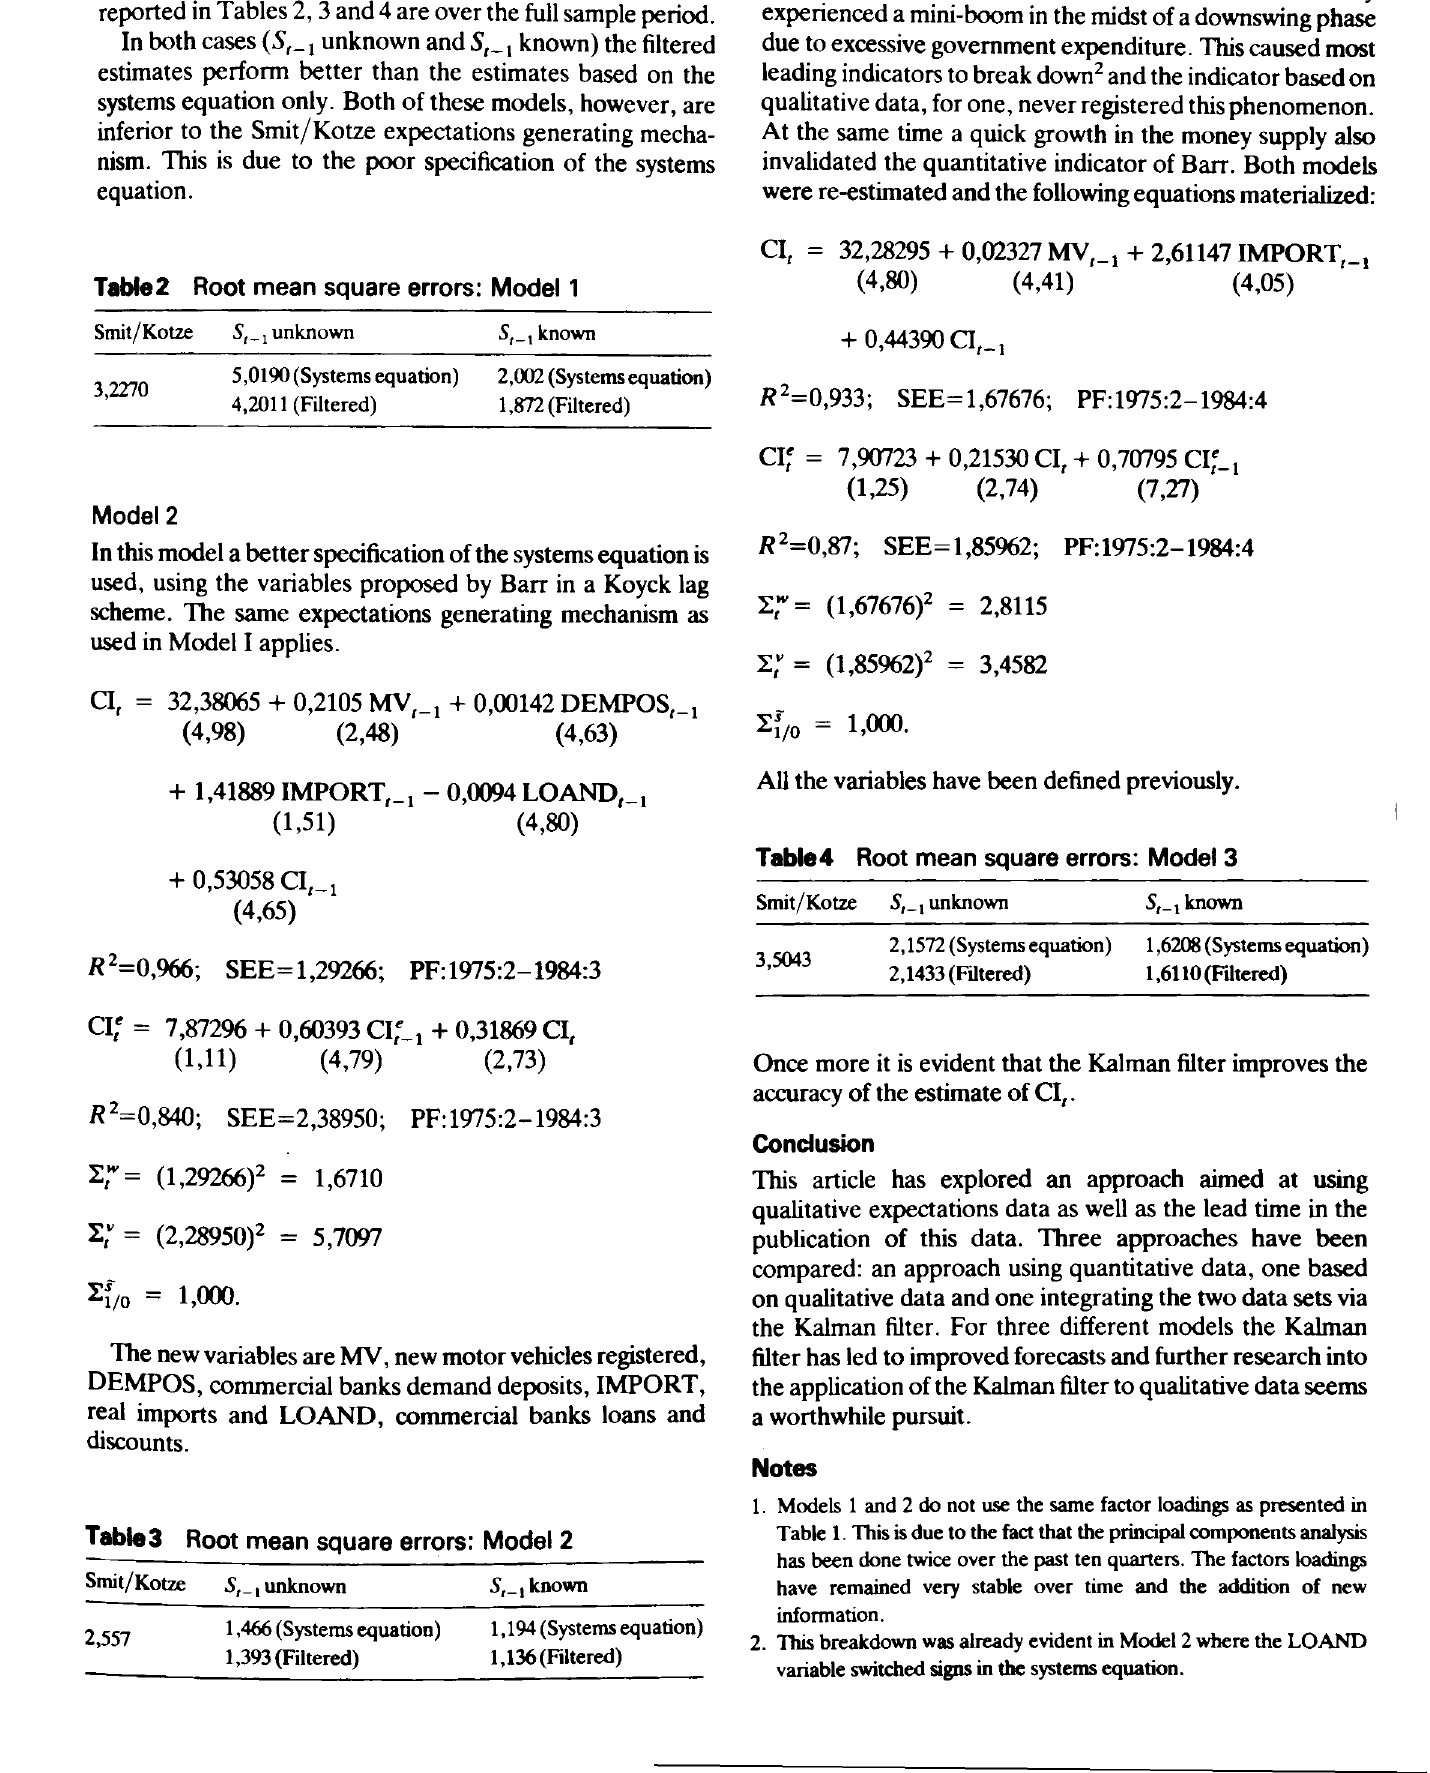
Table3 Root mean square errc;>rs: Model 2